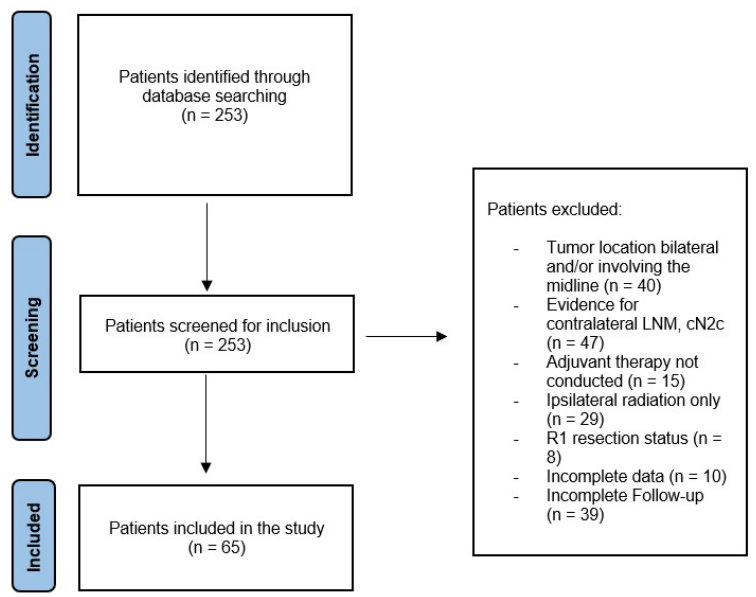
Figure 1. Flowchart demonstrating the process of inclusion.